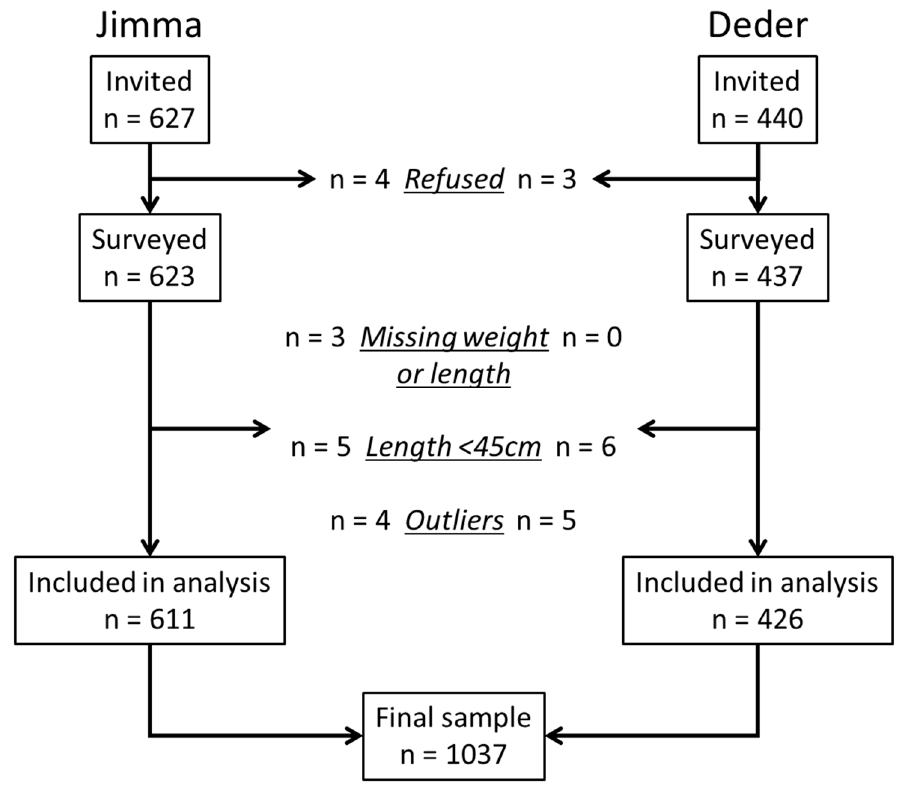
Figure 1. Study participants’ flow chart.